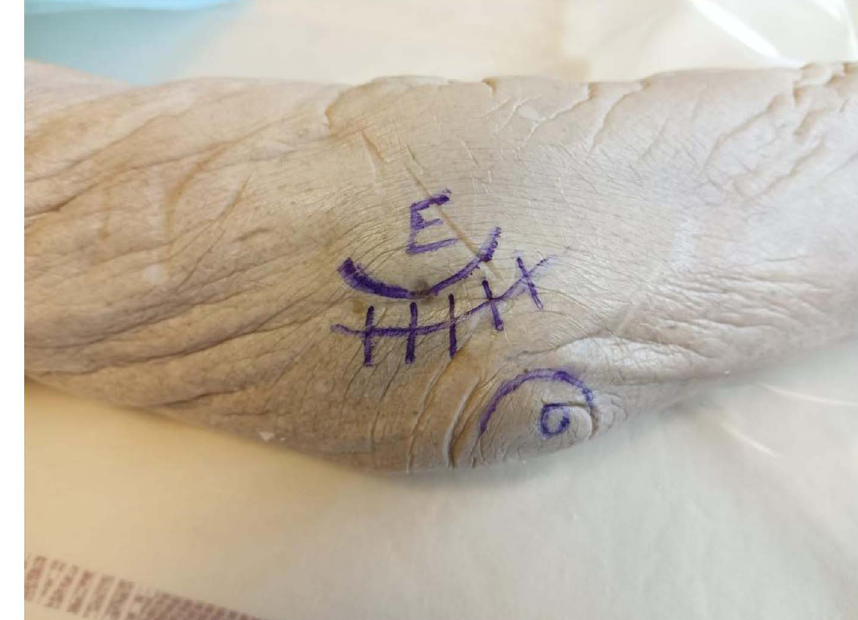
Figure 4. Incision of the open technique.